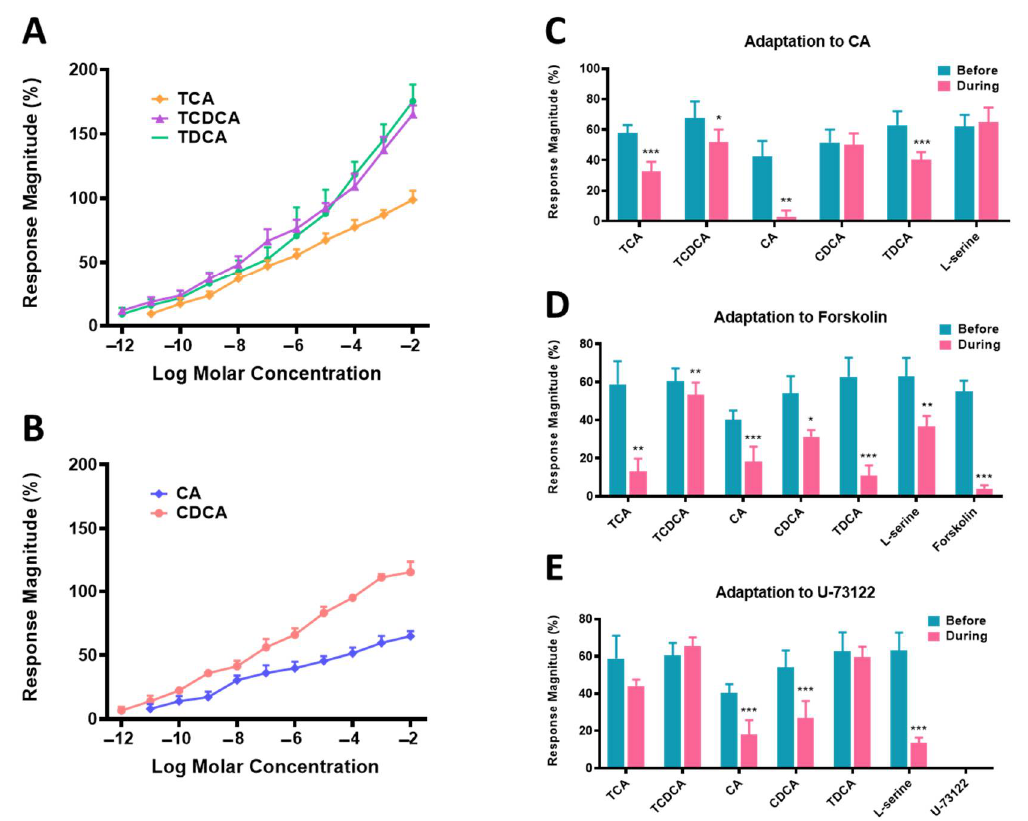
Figure 6. Electro-olfactogram responses of large yellow croaker ( Larimichthys crocea ) to BAs. ( A ) Concentration-response relationships of conjugated and free BAs. ( B ) Response magnitudes of BAs before and during adaptation to 10 − 8 mol/L CA. ( C – E ) The effects of 10 − 7 mol/L forskolin and U-73122 on 10 − 8 mol/L odorant-evoked responses. * p < 0.05, ** p < 0.01, *** p < 0.001; without an asterisk indicates no significant difference according to the paired t -test ( p > 0.05). Response magnitudes are normalized as percentages of the response to 10 − 5 mol/L L-serine (mean ± S.E.M., n = 5). TCA, taurocholic acid; TCDCA, sodium salt of taurochenodeoxycholic acid; TDCA, sodium salt of taurodeoxycholic acid; CA, cholic acid; CDCA, chenodeoxycholic acid.